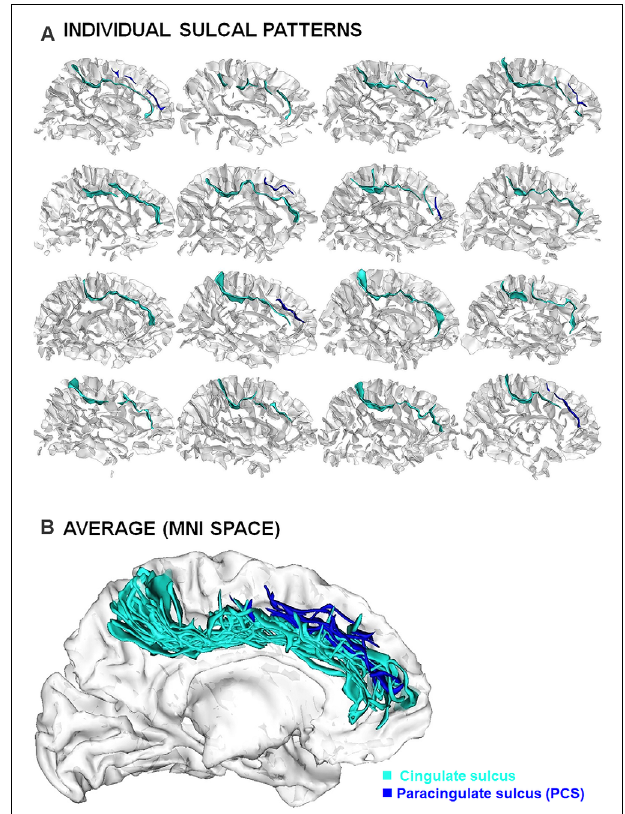
FIGURE 3 | Inter-individual variability of the sulcal patterns. (A) Example of individual ACC sulcal patterns in 12 healthy subjects. (B) Superimposition of individual sulcal patterns in a common reference space (MNI) after linear spatial